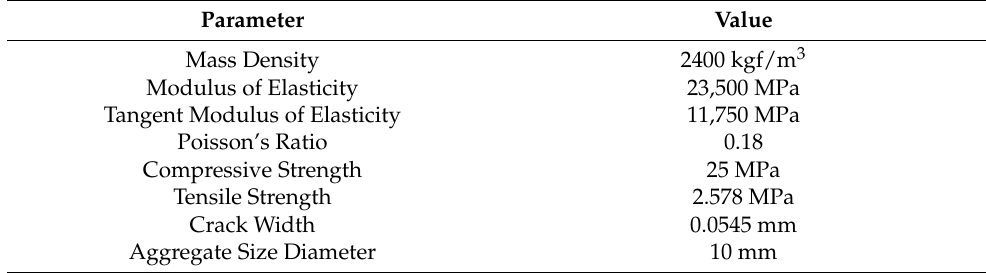
Table 3. Winfrith concrete model input data in LS-DYNA.